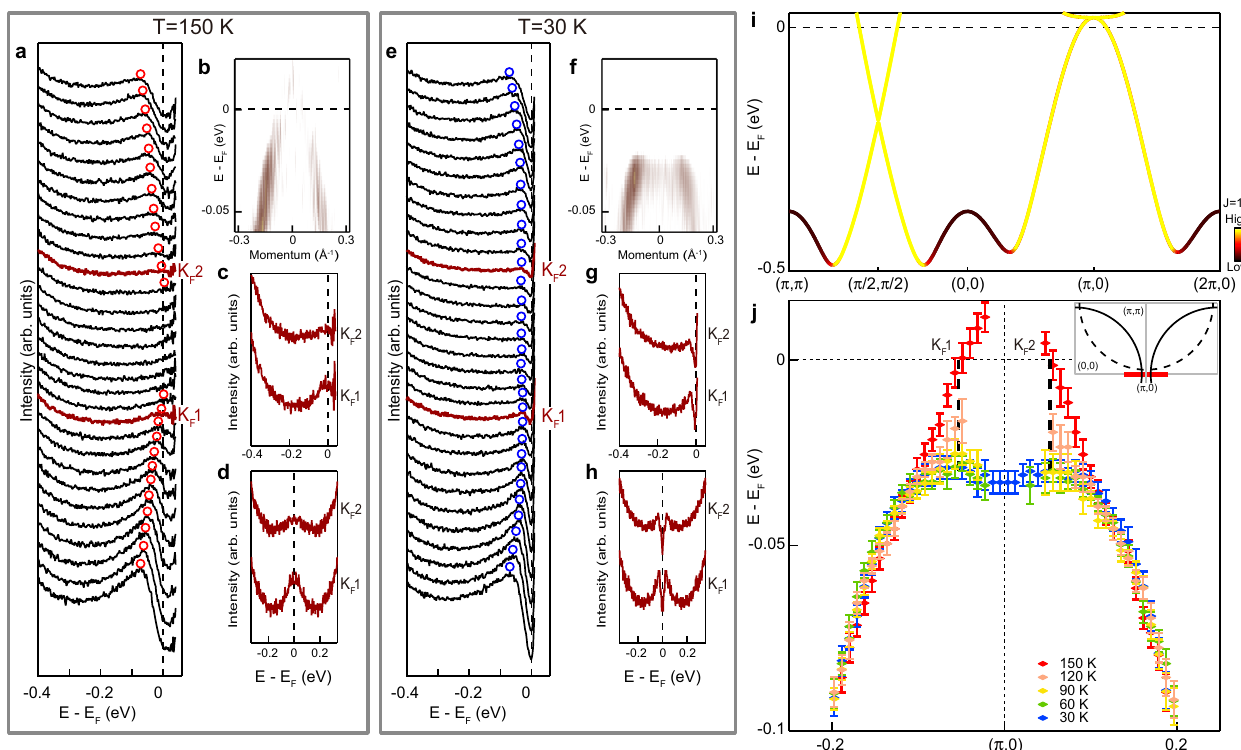
Fig. 1 Temperature dependence of the antinodal band dispersion in electron-doped Sr 2 IrO 4 . a Raw EDCs of the photoemission spectrum along the antinodal cut divided by the Fermi – Dirac function at 150 K. EDC peak positions are marked by the red circles. The two EDCs at the Fermi momenta are shown in dark red and labeled as K F 1 and K F 2. b Second derivative image with respect to the energy of the antinodal dispersion at 150 K. c , d The Fermi – Dirac-function-divided ( c ) and symmetrized ( d ) EDCs at K F 1 and K F 2, shown on an expanded scale. e – h , Same as a – d , but measured at 30 K. i Calculated band dispersions along the high-symmetry directions. The color bar represents the relative weight of J = 1/2 to J = 3/2 states. j Dispersion of the intensity maximum as a function of temperature. The energy error bars represent uncertainties in the determination of the EDC peak positions. The momentum error bars are smaller than the size of the symbol. The curvature of the back-bending behavior at low temperature is small, which also gives rise to some uncertainty in the determination of the exact back- bending position. With this error bar, the back-bending momenta measured at several low temperatures are aligned with the Fermi momenta measured at high temperature. The location of the antinodal momentum cut is shown in the inset. Potassium surface deposition was applied to the La-doped sample (Sr 1 − x La x ) 2 IrO 4 ( x ~ 0.048) to achieve a high electron doping level (Supplementary Fig. 2), where the appearance of low-temperature quasiparticles enables a quantitative determination of the dispersion in the pseudogap state. An undistorted Brillouin zone is used to make a direct comparison with the